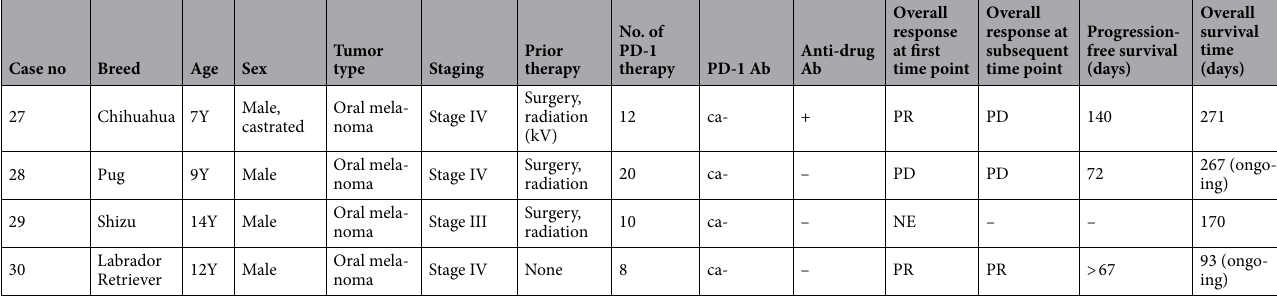
Table 1. Baseline characteristics, treatment course, anti-drug antibody, and survival time in all enrolled dogs.